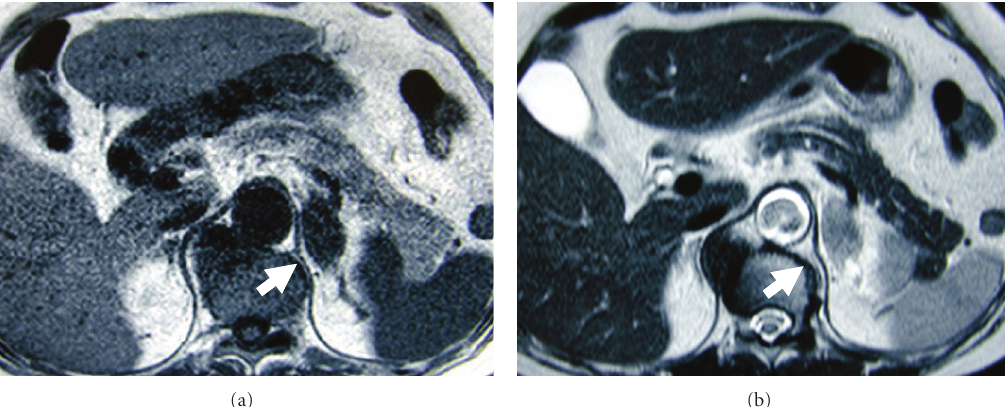
Figure 1: T1-weighted (a) and T2-weighted (b) MRIs of the enlarged left adrenal gland (arrowhead) demonstrating a low- and isointensity signal, respectively. The right adrenal gland was normal in size and shape.